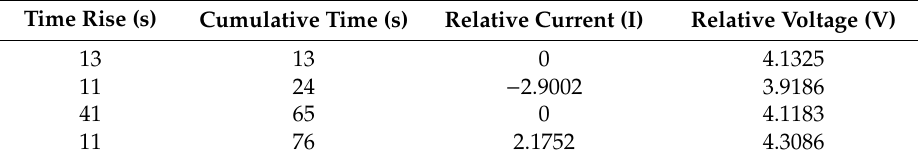
Table 3. Hybrid pulse power characterization (HPPC) test profile table for battery cell1.